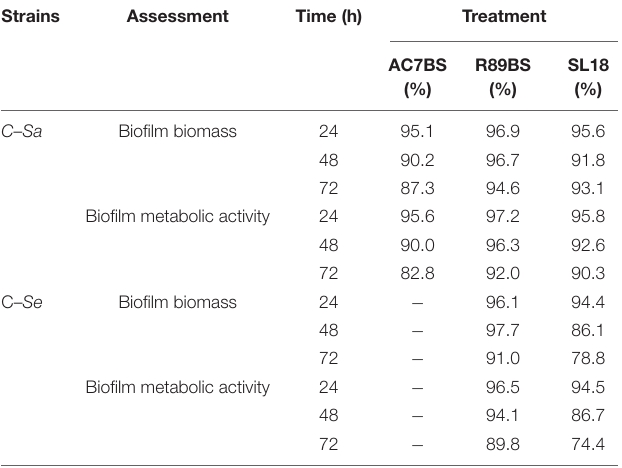
TABLE 2 | Inhibition percentages of dual-species C. albicans–S. aureus and C. albicans–S. epidermidis biofilm formation on BSs treated silicone discs by CV (biofilm biomass) and MTT assays (biofilm metabolic activity).